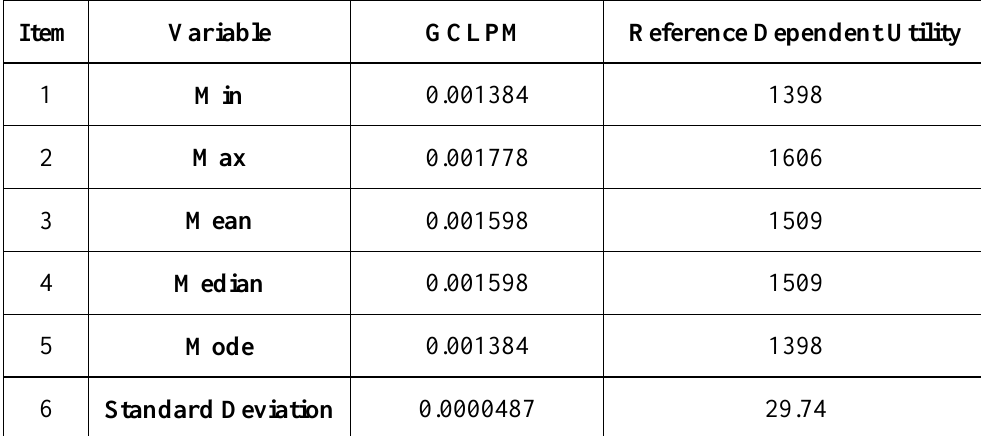
Table 7. Result Specification of Scenario 2 in Second